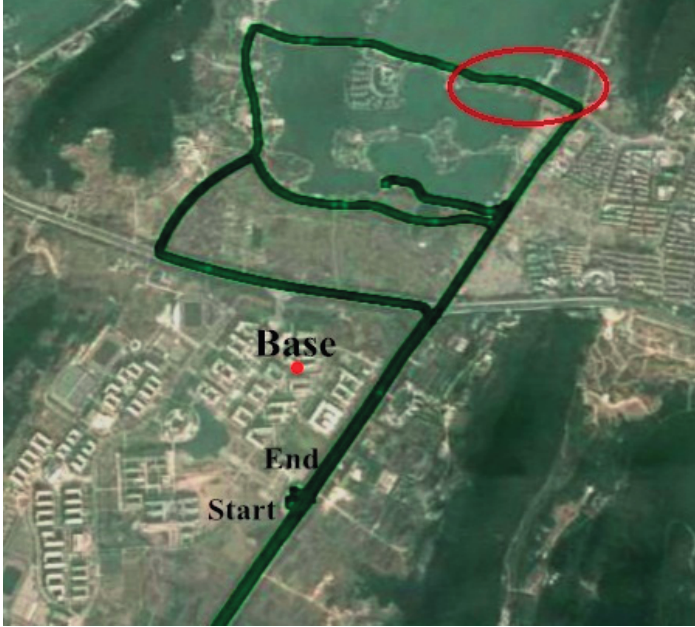
Figure 4. Field test trajectory (vehicle operated under foliage in the area marked by a red